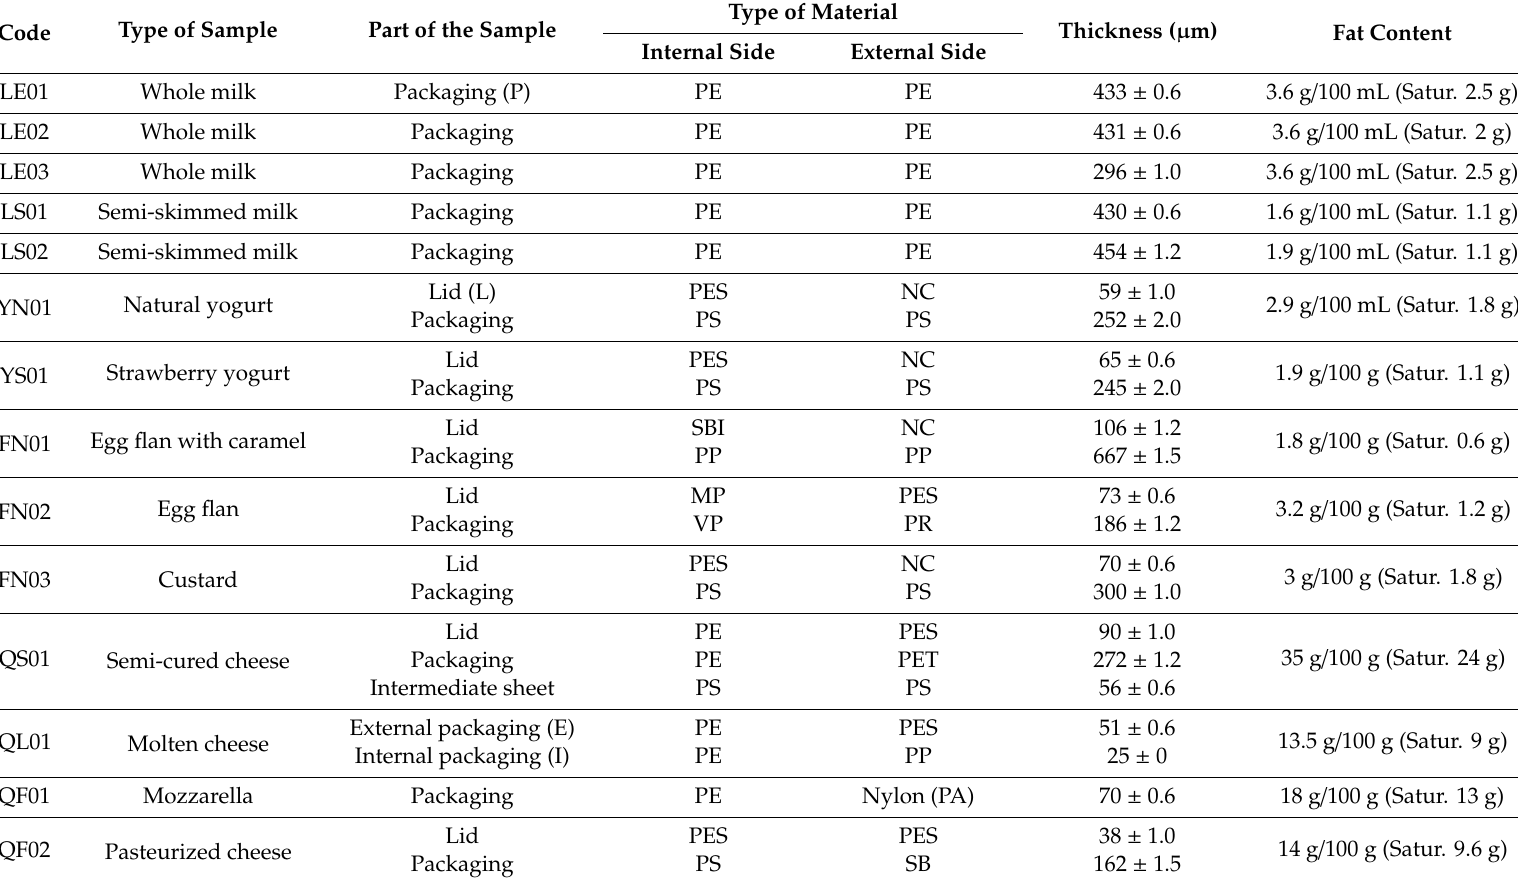
Table 1. Summary of the food samples included in the study, fat content, type of packaging material, and